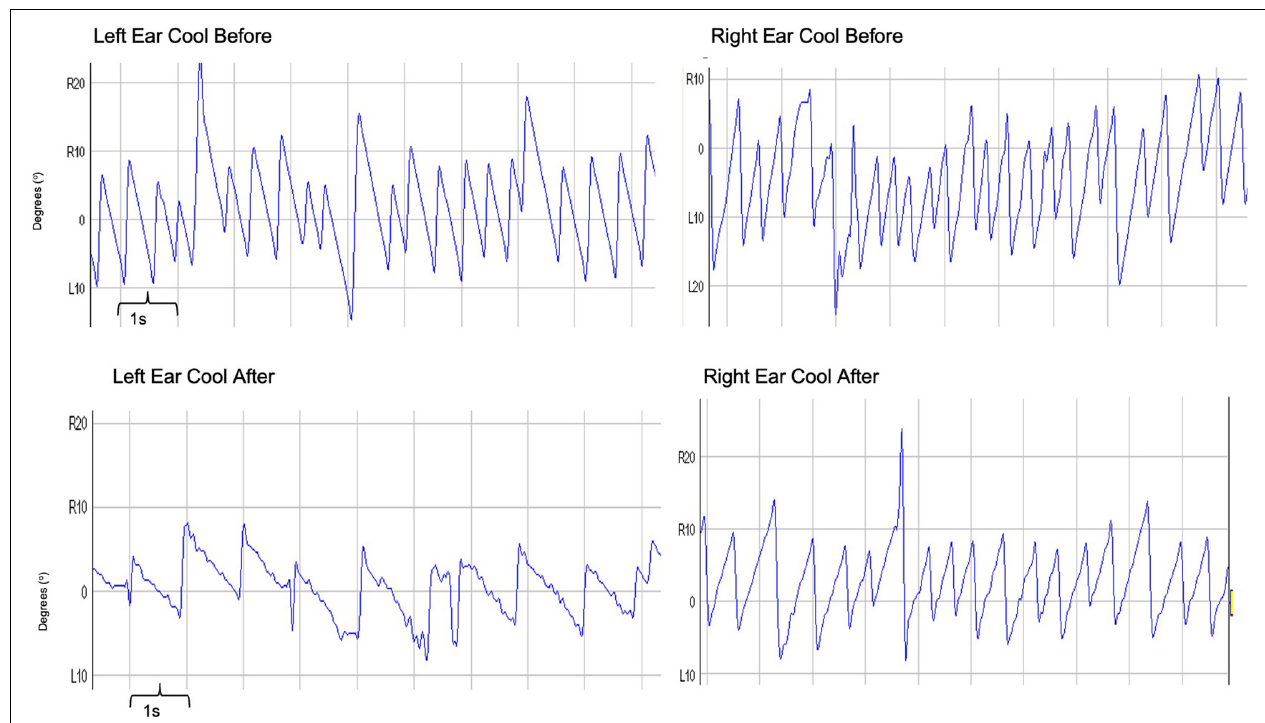
FIGURE 3 | Trace depicting caloric-induced vestibular nystagmus: Raw traces obtained before and after the application of left hemisphere cathodal tDCS. Right-ear cold irrigations are represented in the right panel, whereas left-ear cold irrigations in the left panel. The recordings before tDCS are on the top with after tDCS traces represented on the bottom. The x -axis represents time, with one large square representing 1 s. The y -axis represents the degrees of eye movement either right (R) or left (L) from the center (0 ◦ ). To measure the slow phase velocity of a nystagmus, one utilizes the slope of the nystagmus in its slow phase. In these recordings, one can clearly see a less steep slope, and therefore a suppressed slow phase velocity of the nystagmus following cathodal tDCS – for both right and left ear cold irrigations.